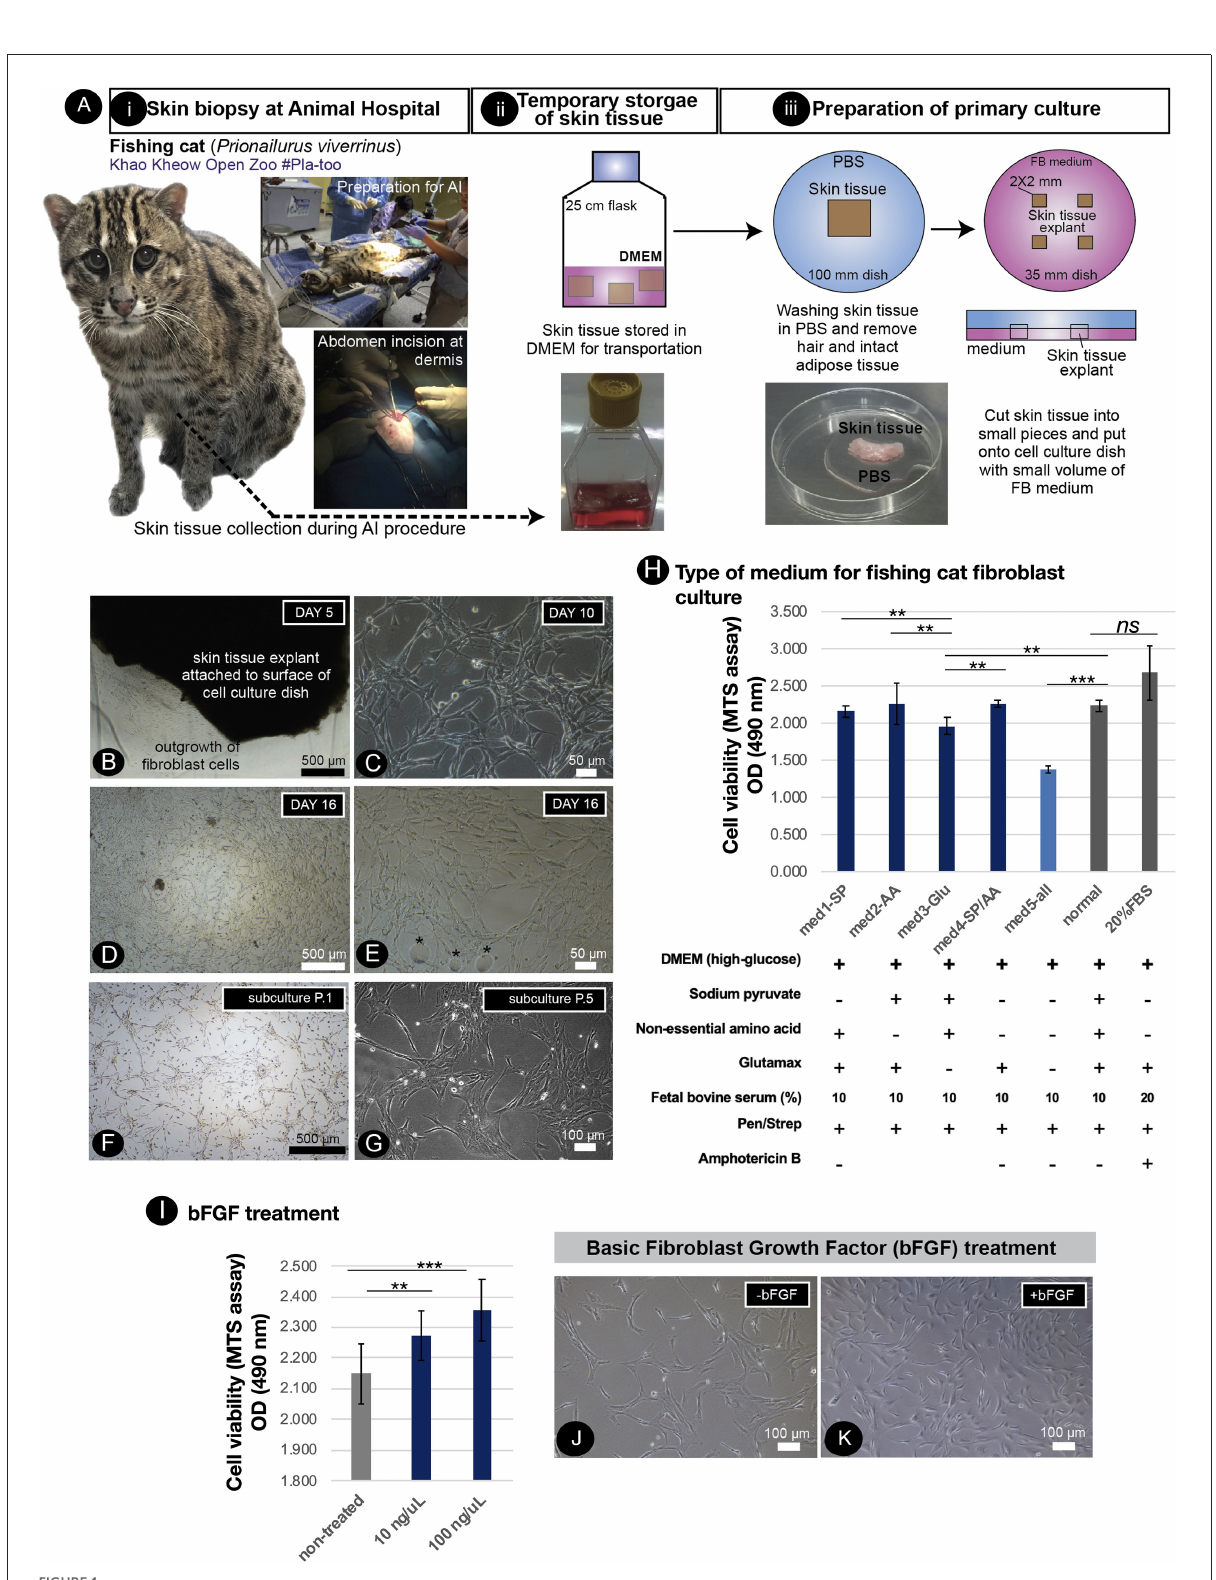
FIGURE1 Primary culture of fishing cat cells and conditions supporting fishing cat cell expansion. (A) Tissue collection and preparation for primary culture: (i) skin biopsy was performed by veterinarians during artificial insemination of fishing cat. (ii) The skin tissues were then transported to the